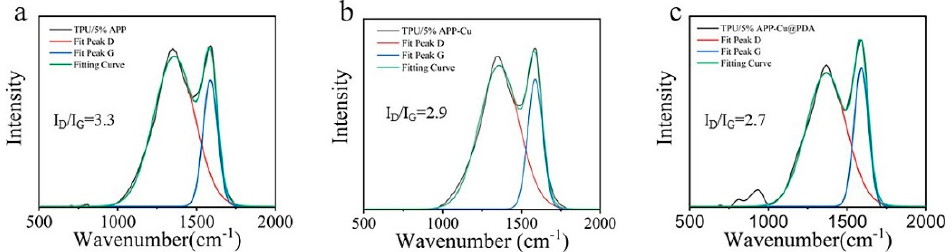
Figure 8. Raman spectra of residues for ( a ) TPU/5%APP, ( b ) TPU/5%APP-Cu, and ( c ) TPU/5%APP-Cu@PDA.